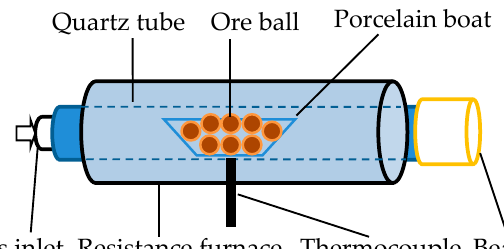
Figure 1. Schematic illustration of roasting test.